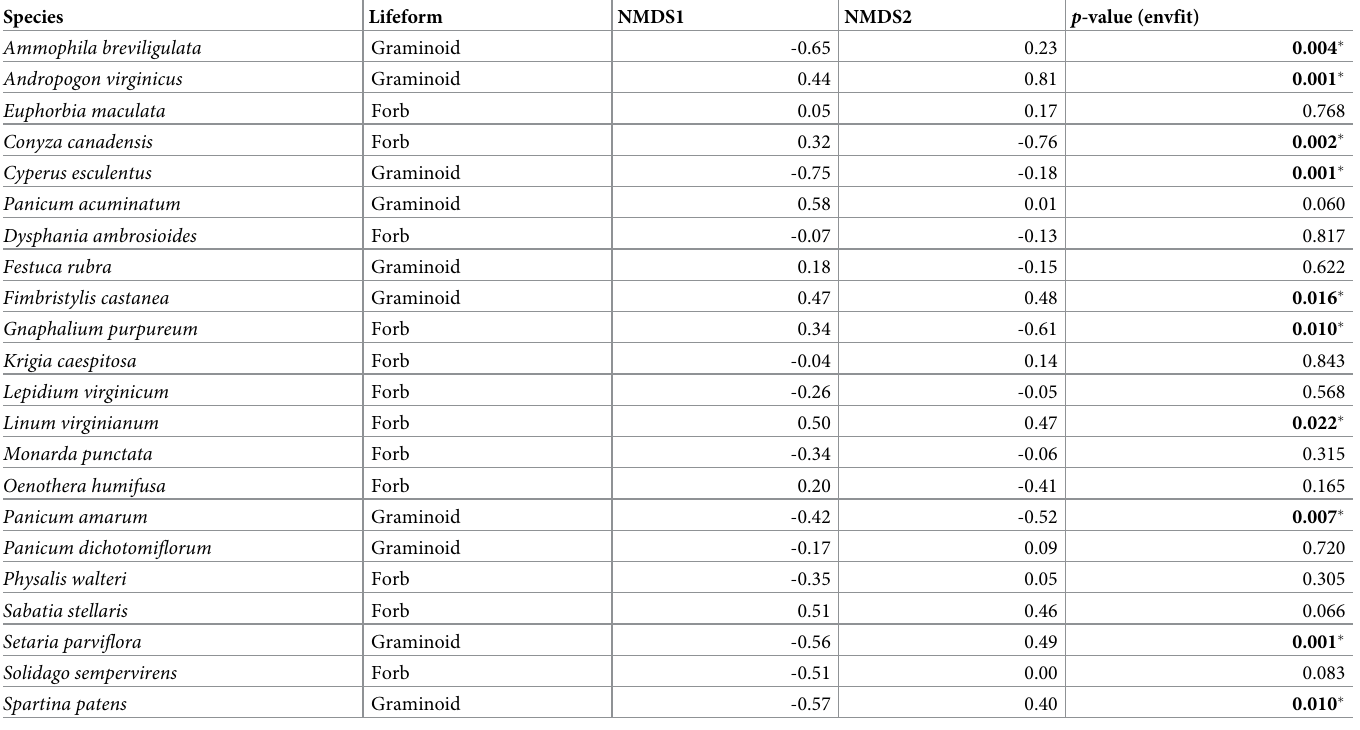
Table 2. Species information with NMDS correlations along axis 1 and 2 and results from envfit randomization test.